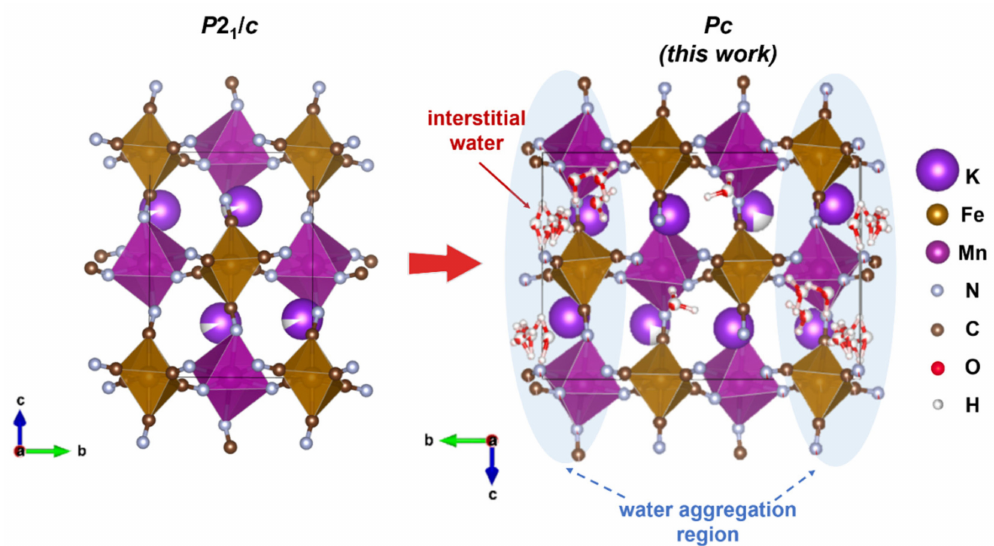
Figure 3. Comparison of crystal structure projections of K 2 − δ Mn[Fe(CN) 6 ] 1 − δ · nH 2 O (data collection temperature, 300 K) with SG. P 2 1 / c [29] and Pc (this work). Blue ovals designate a water aggregation